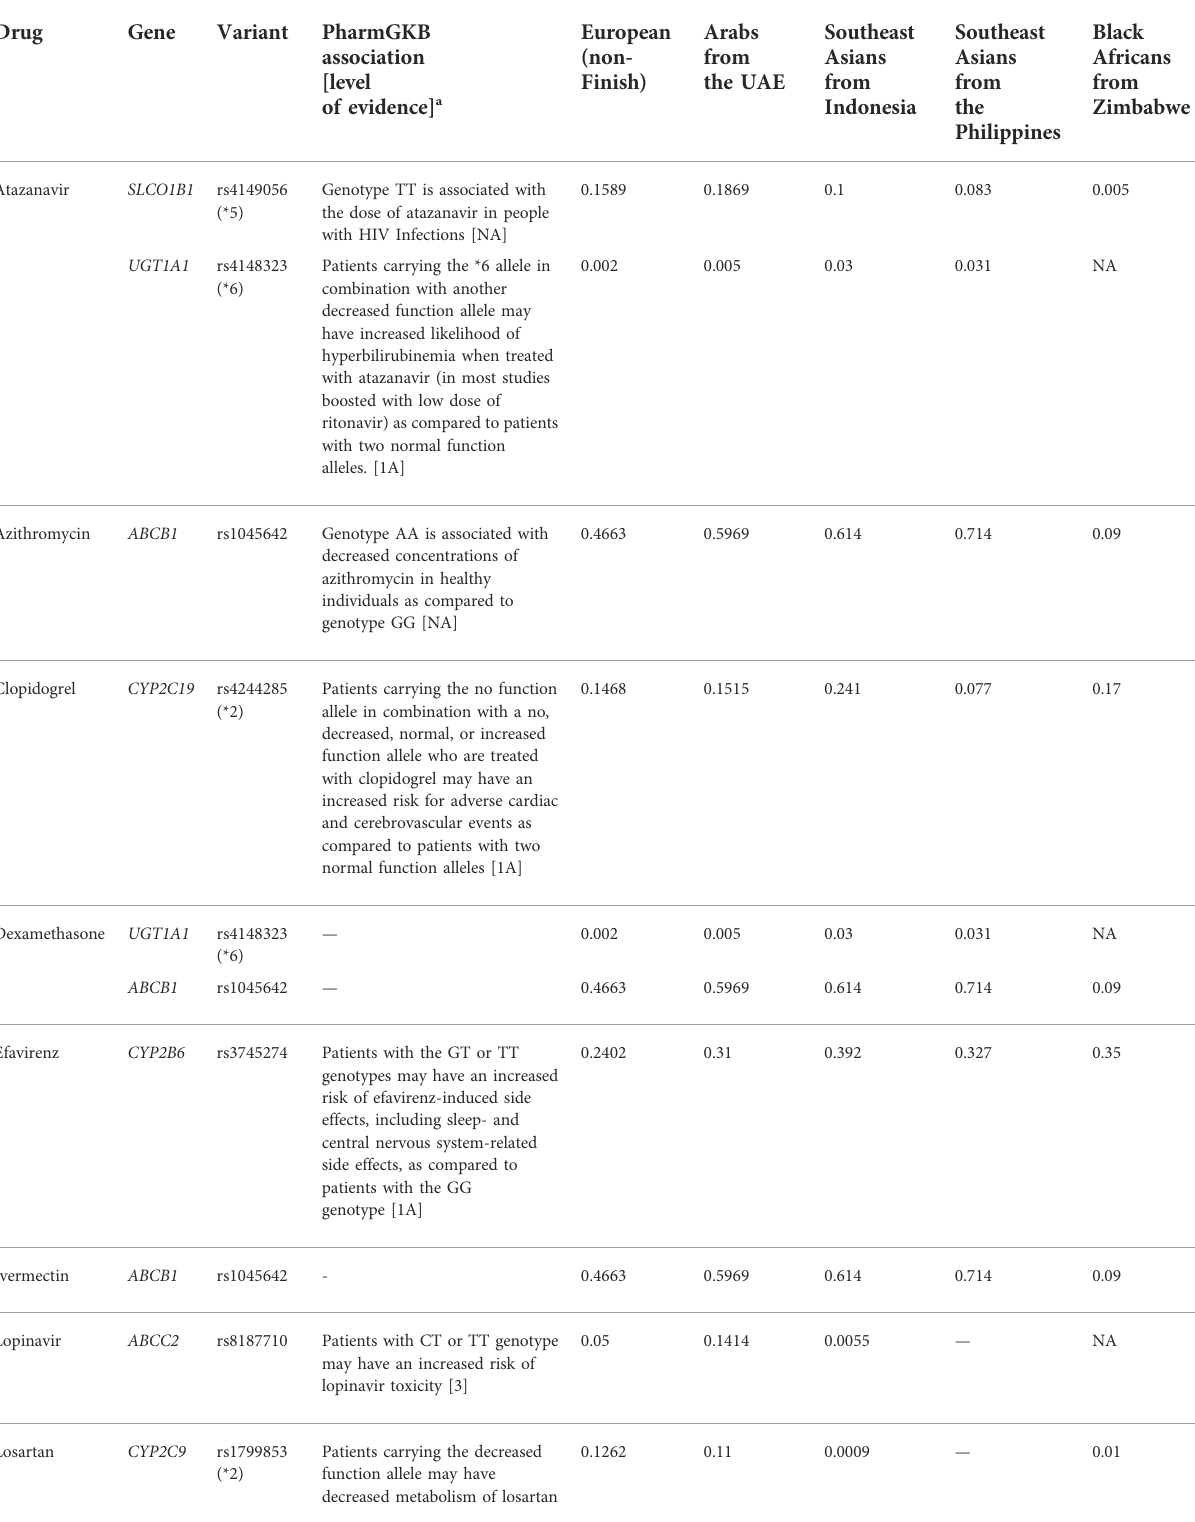
TABLE 1 Examples of the suggested gene-drug pairs related to the management of COVID-19 and the frequencies of their minor allelesin Europeans compared to selected rarely-studied populations. Drug